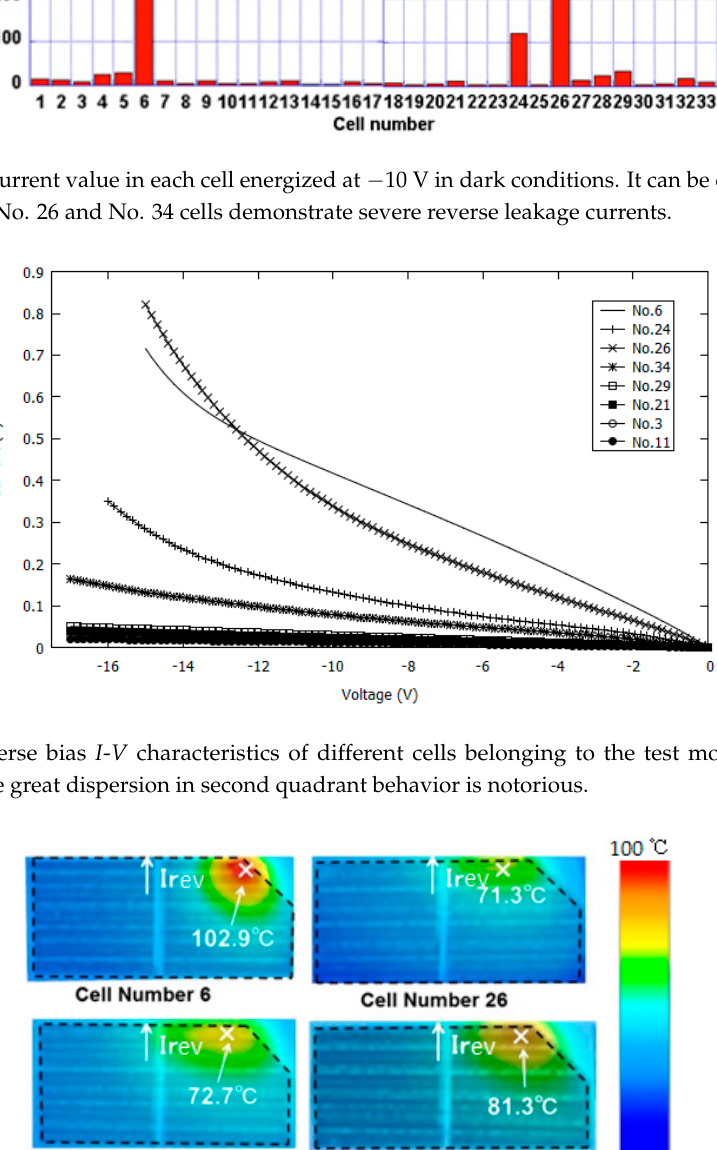
Figure 4. IR images of fully shaded defective cells. It can be observed that hot-spots tend to occur near the edge of defective cells.